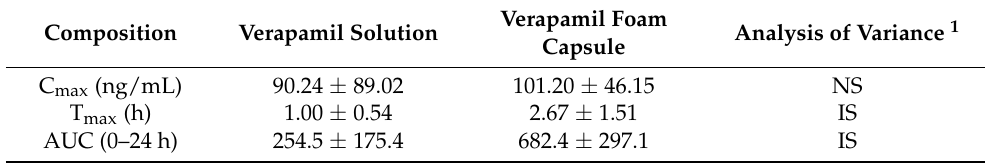
Table 5. The main pharmacokinetic properties are summarized. The Verapamil foam capsule showed significantly different results in T max and AUC compared to the